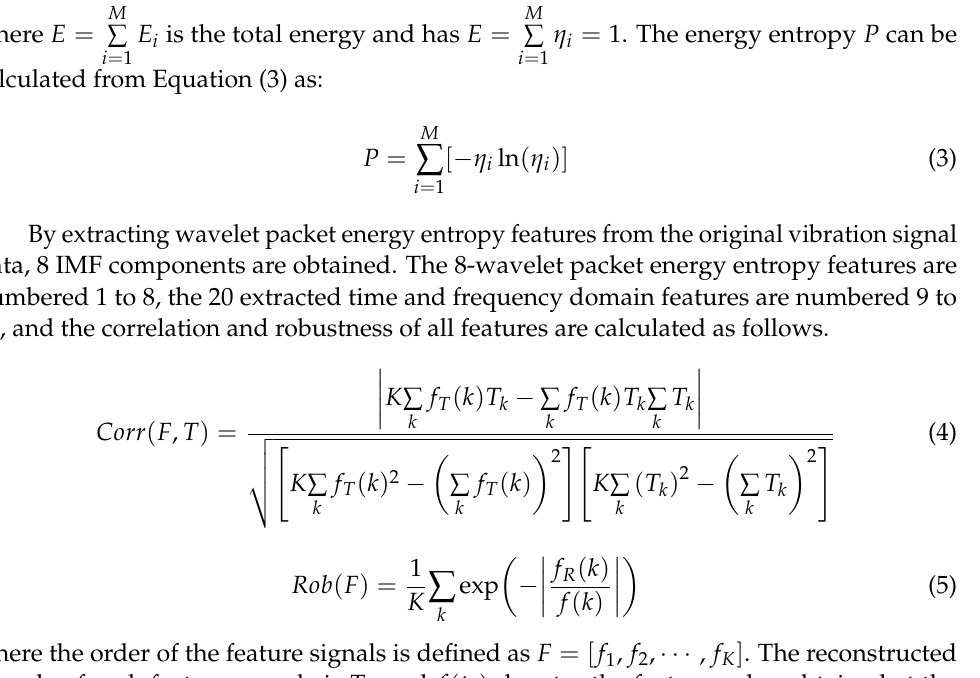
s X Figure 3. Fuzzy subsystem structure. In Figure 2, it is assumed that there are n fuzzy subsystems and m groups of augmented nodes in FBLS. The input data are